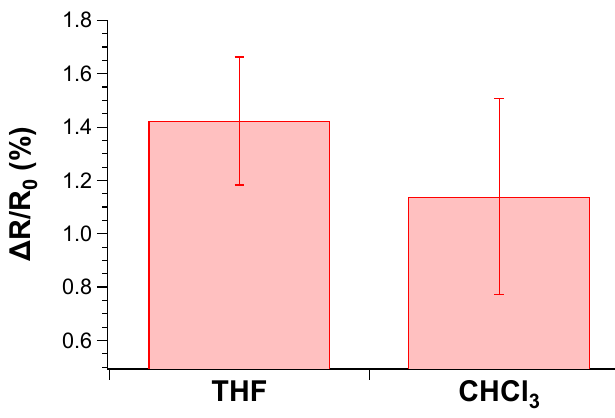
Figure 11. Comparison of responses from the sensing elements to the 25 ppm VOCs.